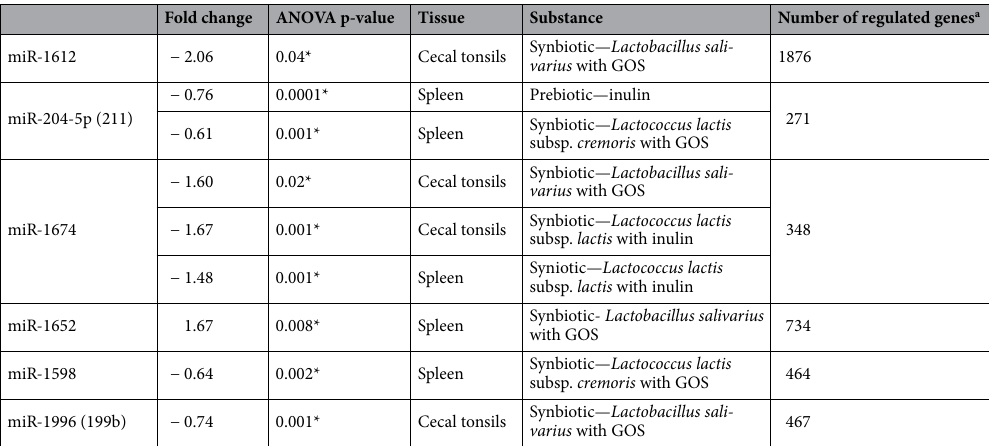
Table 1. Changes in miRNA expression read from the expression microarray in cecal tonsils and spleen after administration of bioactive substances in ovo on day 12 of egg incubation. a Quantitative analysis of genes regulated by miRNA data using the TargetScan software (targetscan.org); *P < 0.05, GOS